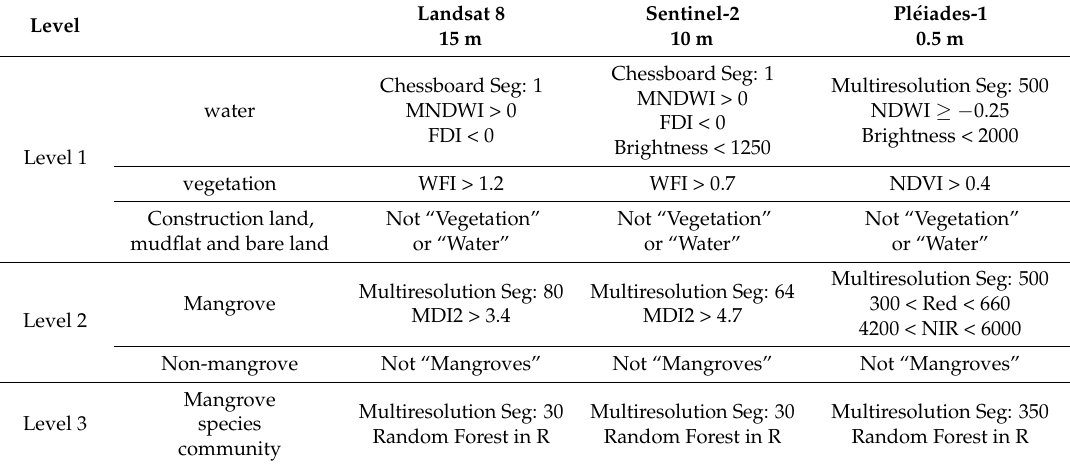
Not “Vegetation” or